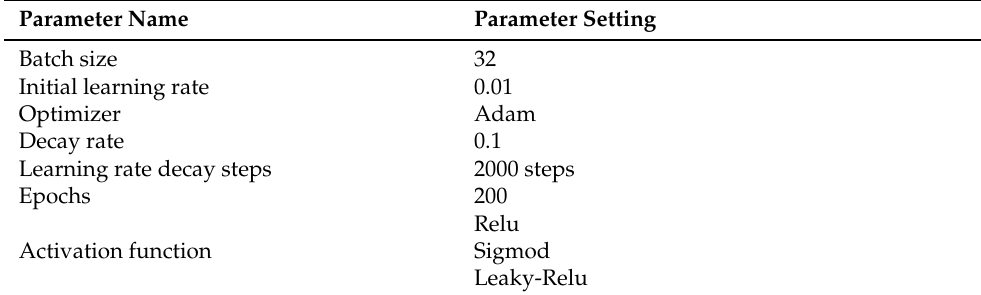
Table 2. Hyper-parameters setting of SRT